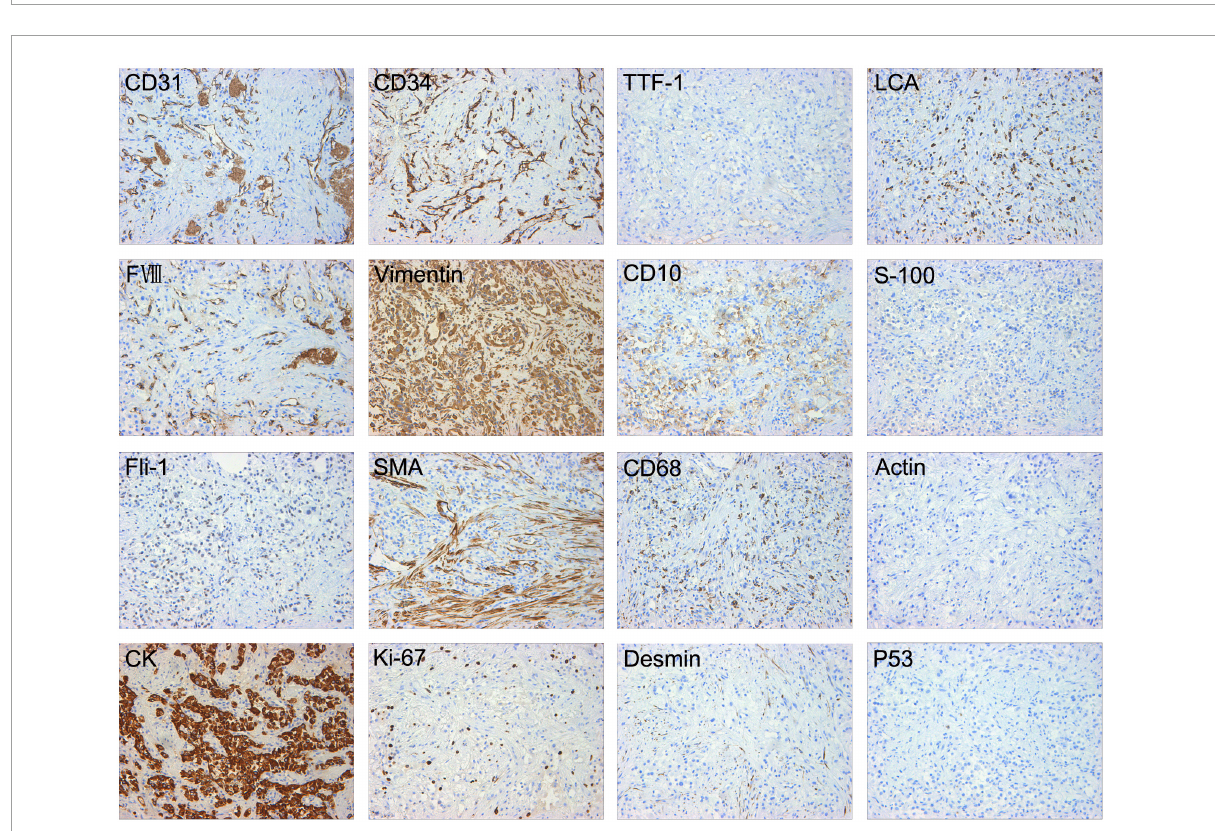
FIGURE3 Immunohistochemical stains showed positive staining of the tumor cells for CD31, CD34, Fli-1, CK, Vimentin, FVIII, CD10, and Ki-67 (20%). Desmin, Actin, SMA, CD68, TTF-1, P53, S-100, and LCA were negative in the tumor cells.